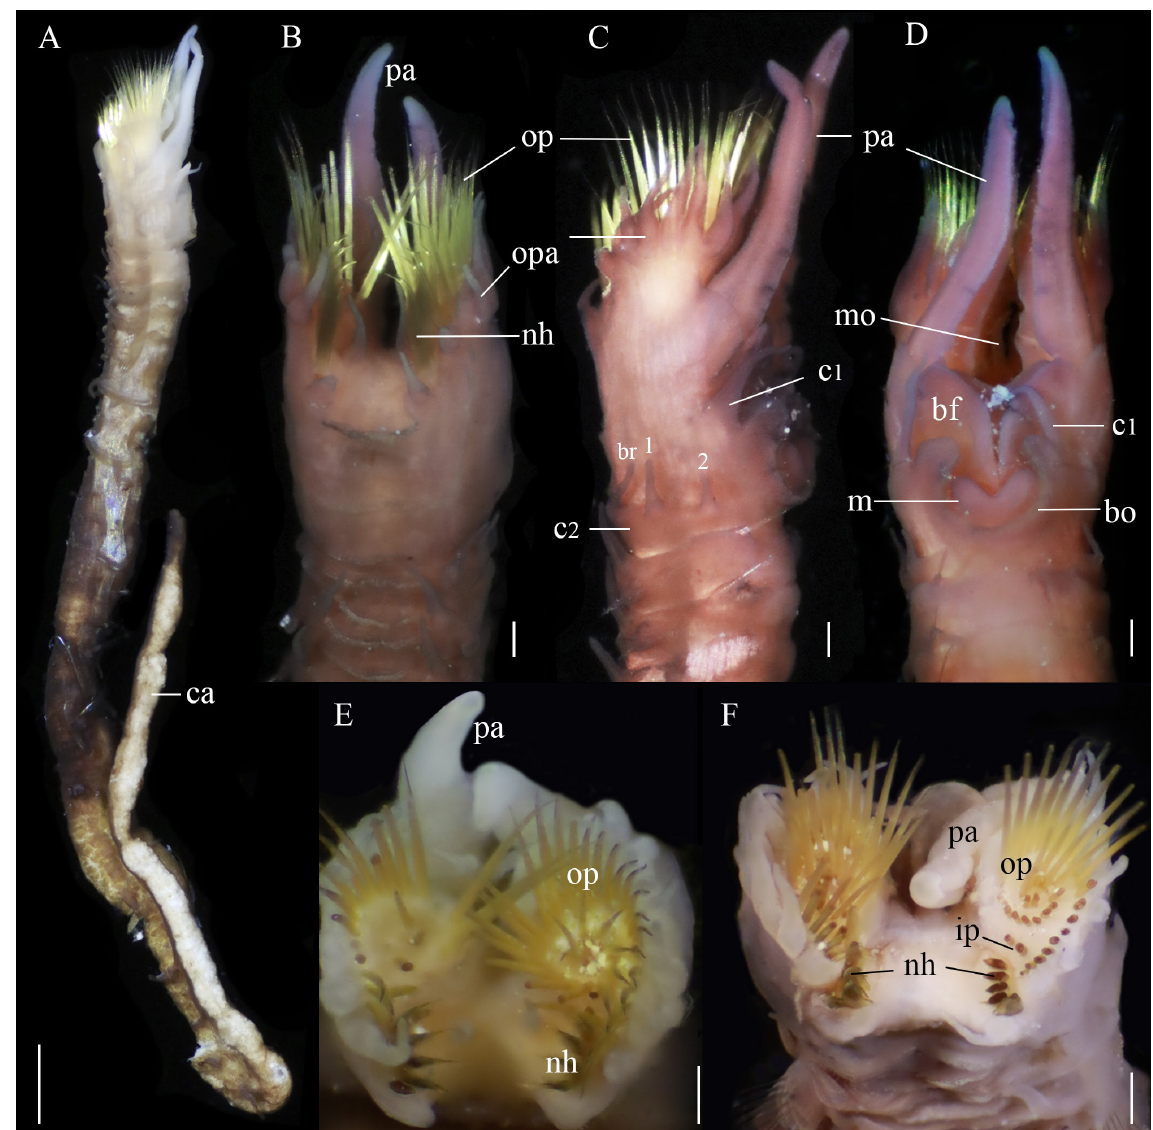
Fig. 9. Phalacrostemma dorothyae Kirtley, 1994 (UMML-22.1183). A . Complete specimen, lateral view. B . Anterior region, dorsal view. C . Anterior region, lateral view. D . Anterior region, ventral view. E . Opercular crown, upper view. F . Opercular crown of another specimen (UMML-22.1183), upper view. Abbreviations: bf = buccal flaps; bo = building organ; br = branchiae; ca = caudal peduncle; c1 = cirri 1 st thoracic segment; c2 = cirri 2 nd thoracic segment; ip = inner paleae; m = mount; mo = median organ; nh = nuchal hooks; op = outer paleae; opa = opercular papillae; pa = palps. Scale bars: A = 1 mm; B–F = 0.2